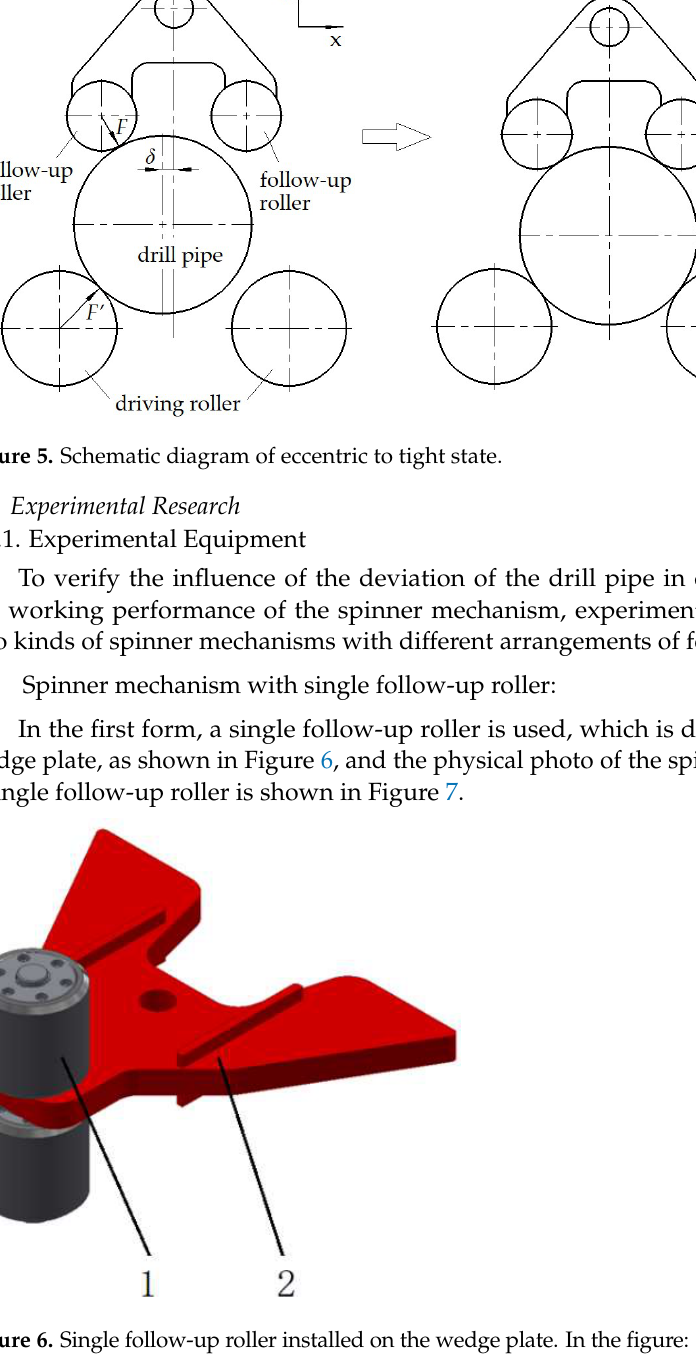
Figure 7. Spinner mechanism with single follow-up roller. In the figure: 1—driving roller, 2—fol- low-up roller. 2. Spinner mechanism with double follow-up rollers: In the second form, double follow-up rollers are symmetrically arranged, and the follow-up rollers are installed on the wedge plate through the roller bracket, as shown in Figure 8. Figure 9 is a photo of the spin-rollers holding the drill pipe tightly, and the driv- ing roller is replaced with a combined roller, which further increases the friction and is convenient for disassembly and replacement. It is evident from the figure that each roller is in good contact with the drill pipe.